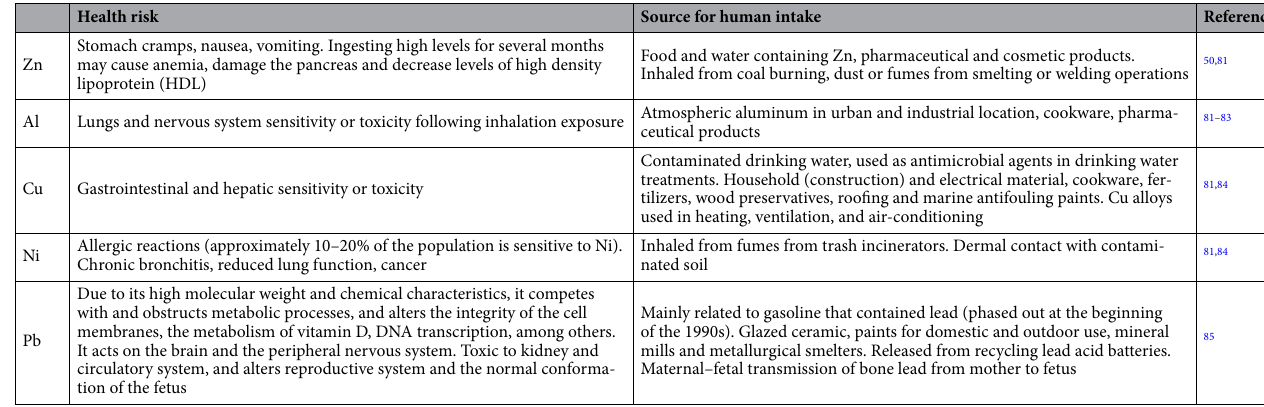
Table 6. Health risk and possible sources for human intake of the metals zinc, aluminum, copper, nickel and